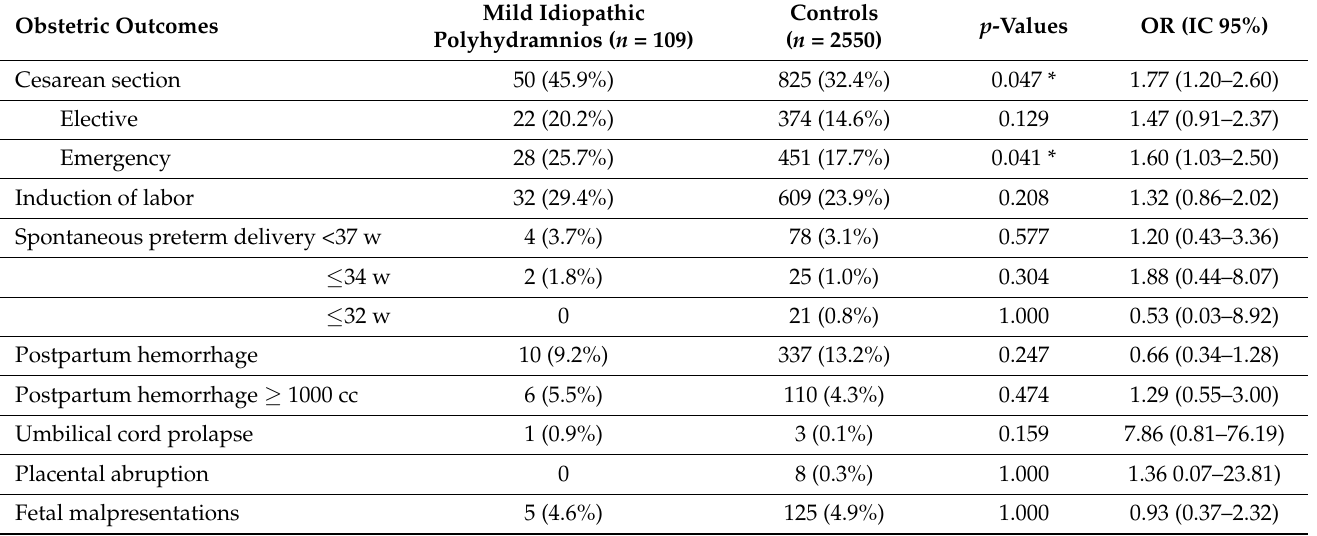
Table 2. Obstetric outcomes of the study population and control group.